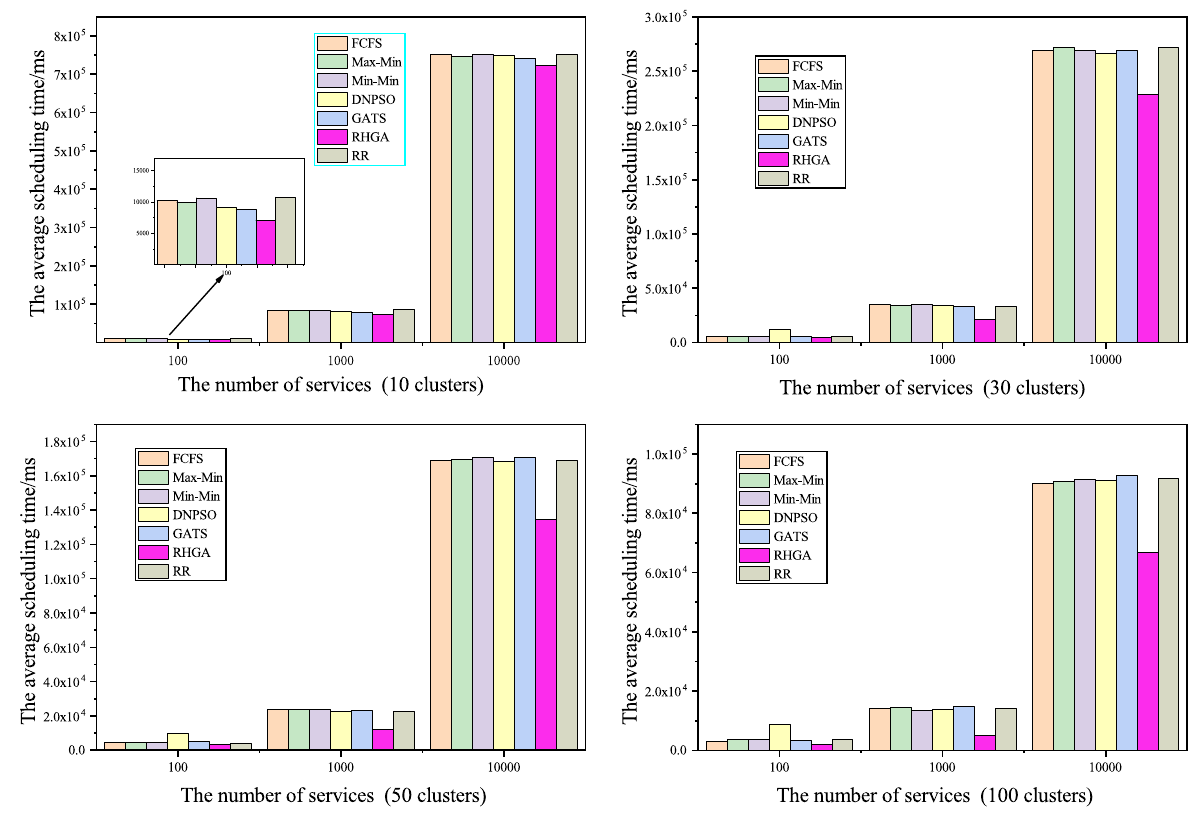
Fig. 6 The average scheduling time of various